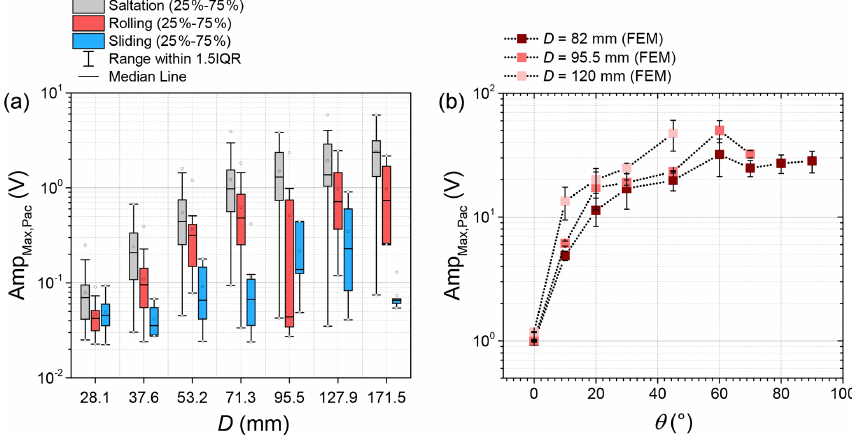
Figure 9. (a) Maximum amplitude Amp Max , Pac versus bedload particle size D for different transport modes. (b) Amp Max , Pac versus impact angle θ for different particle sizes. FEM denotes simulations with the finite element